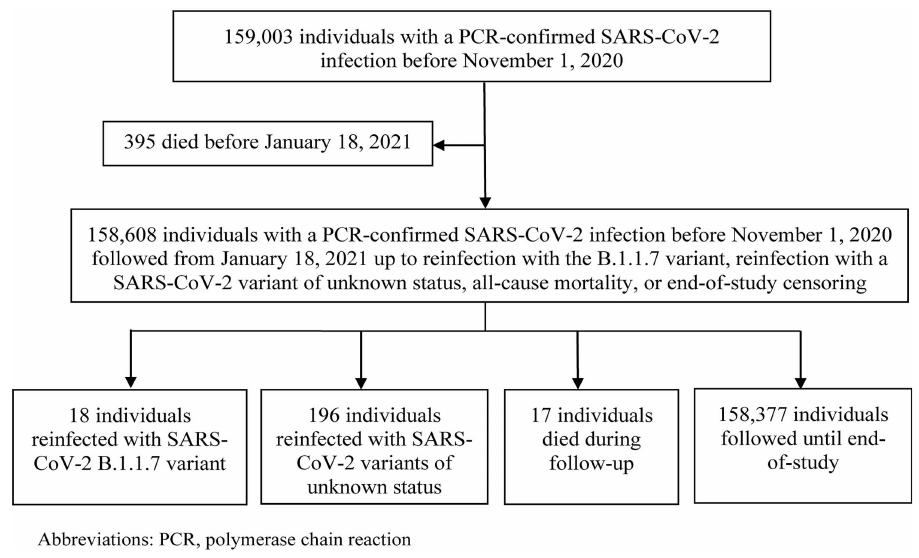
Fig 3. Flow chart of SARS-CoV-2 reinfections with B.1.1.7 and variants of unknown status in the national cohort of individuals with prior PCR-confirmed